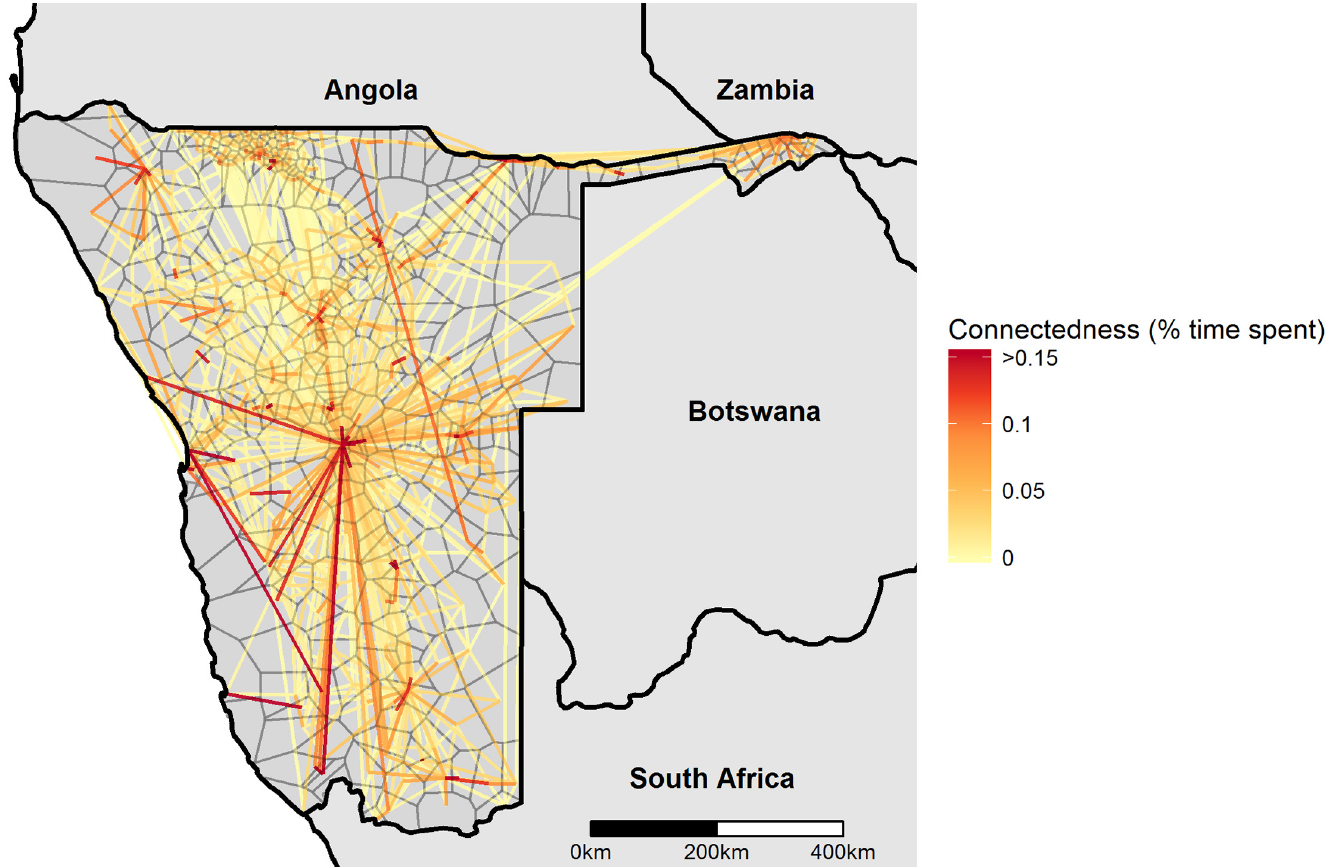
Fig 7. Patch-level connectivity. Patch boundaries drawn using Voronoi polygons around cell towers shown in thin black lines. Connectivity shown between patch centroid, with line color (yellow/red) representing the proportion of time people in each patch spend in the other (average of both directions shown). Higher values indicate better-connected pairs of patches. Only the top 2% of pairwise connections are